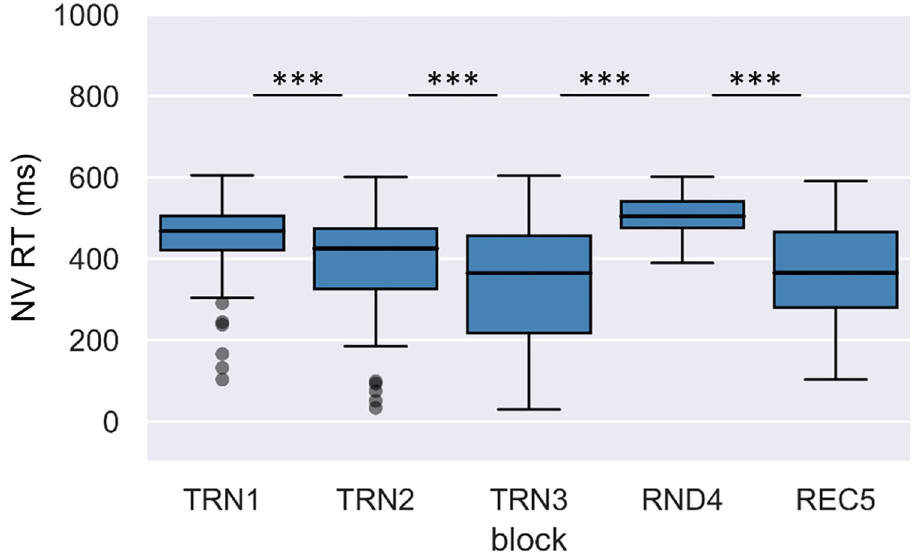
Fig 5. Change of median reaction times across blocks in the nonverbal visual condition. Boxes indicate RT data between the first and third quartiles, horizontal lines indicate medians, and whiskers illustrate the range of data, and individual dots outside the range represent outliers.